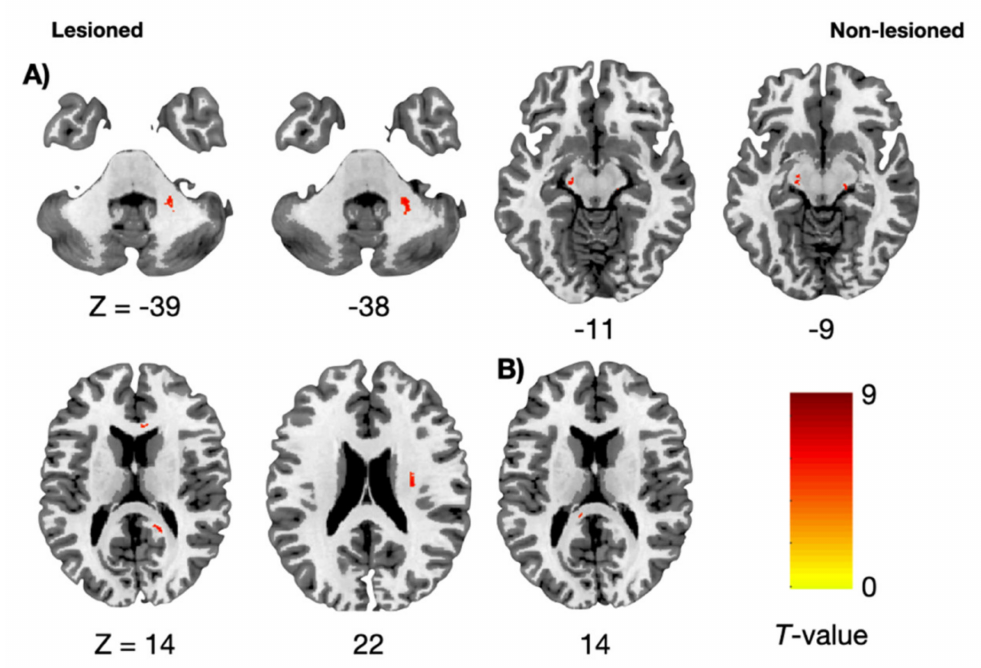
Figure 2. Regression analysis associated with functional ambulation category. ( A ) Fractional anisotropy maps associated with functional ambulation category. ( B ) Mode of anisotropy maps associated with functional ambulation category. z: z -axis in the Montreal Neurological Institute space. Statistical threshold: P FWE <